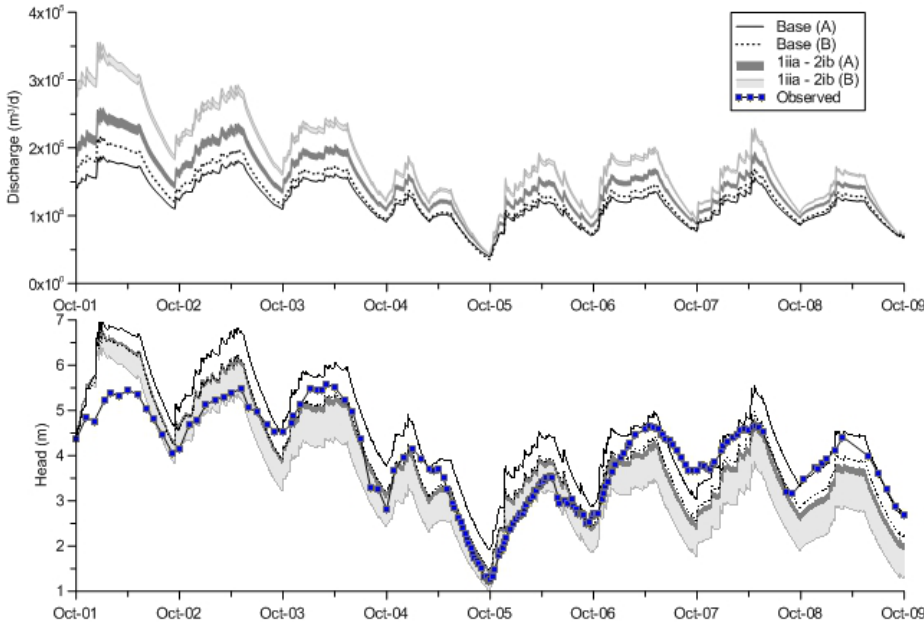
Fig. 4. Simulated discharge and hydraulic head at piezometer 595/215 from 2001 to 2009 for the various distributions of T